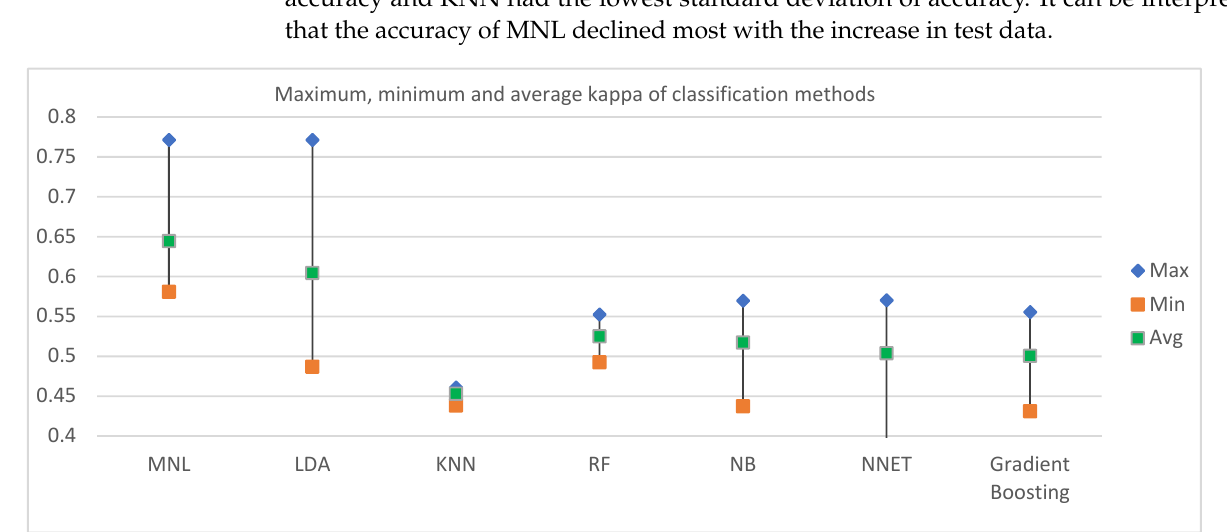
Figure 1. Maximum, minimum, and average accuracy of classification methods.